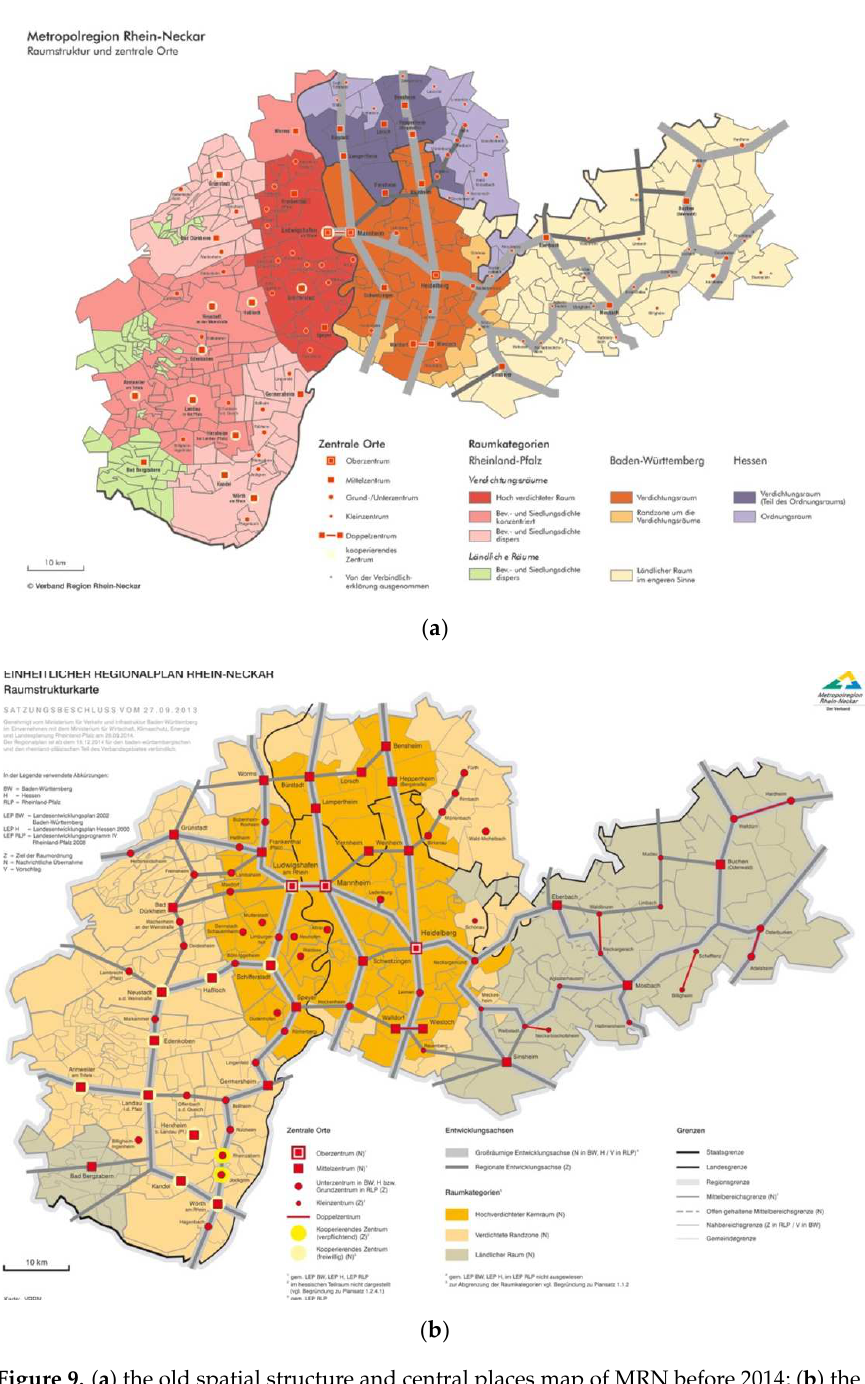
Figure 9. ( a ) the old spatial structure and central places map of MRN before 2014; ( b ) the new spatial structure map of MRN in the standardized Rhine-Neckar regional plan since 2014. Source: Verband Region Rhein-Neckar .